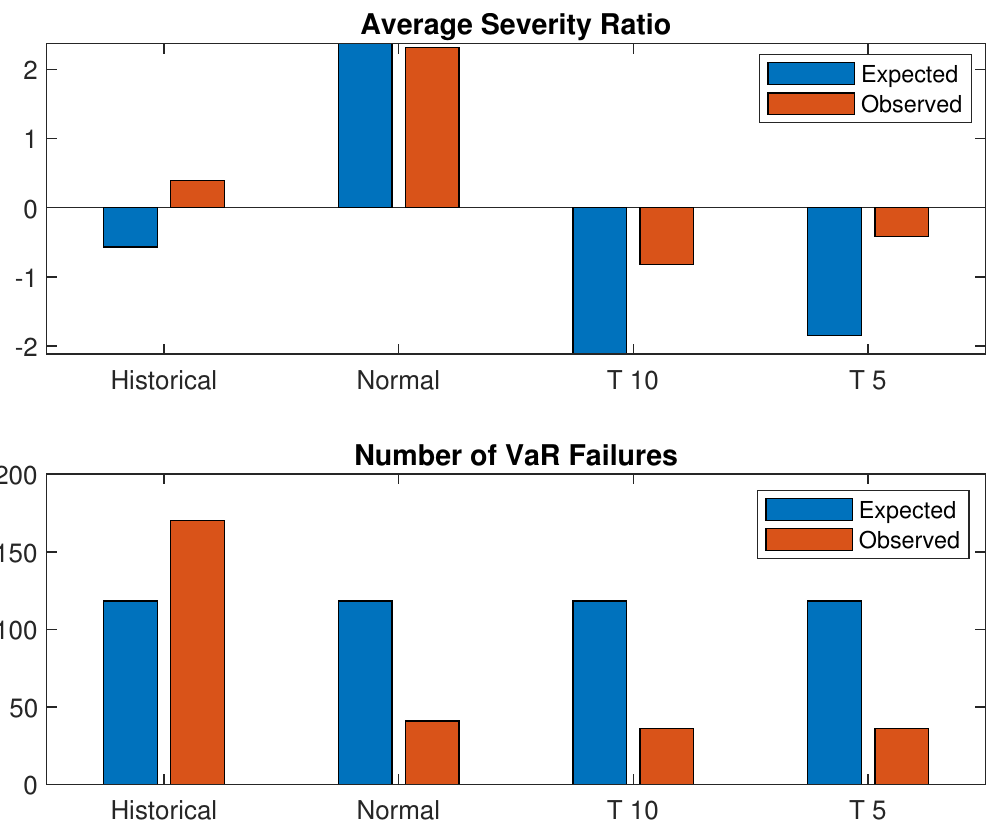
Figure A1. Severity of VaR failures relative to the ES estimate and to the number of VaR failures.